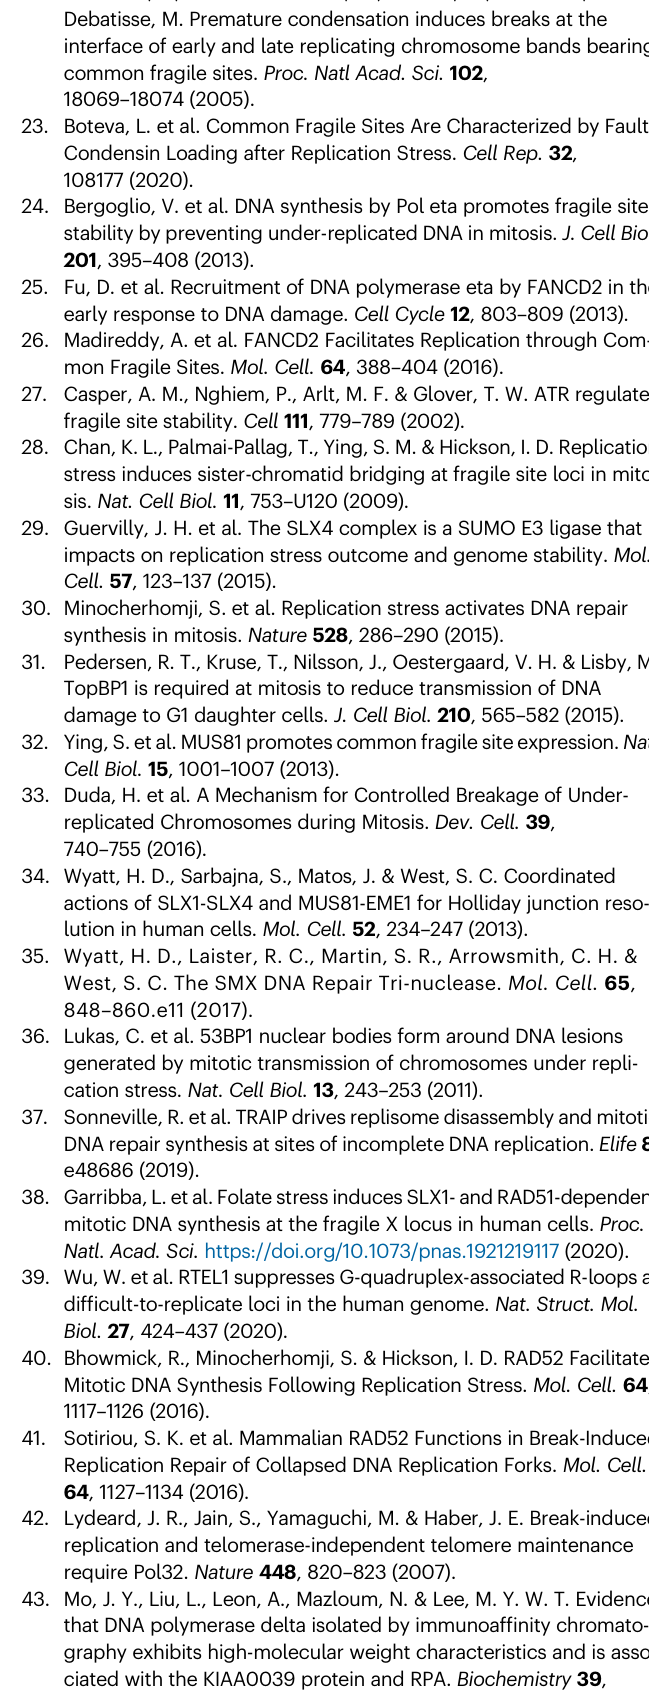
fi le. The source data for all of the images in fi gures are deposited at Figshare via https:// fi gshare.com/s/e17deec87055270ae64d. Source data are provided with this